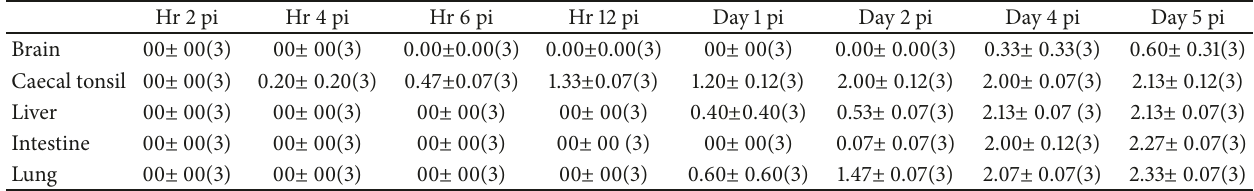
Table 8: Lesion scoring (0-3) induced by vNDV in HE stained tissues of proventriculus, thymus, and heart collected from hr 2 till day 5 pi.